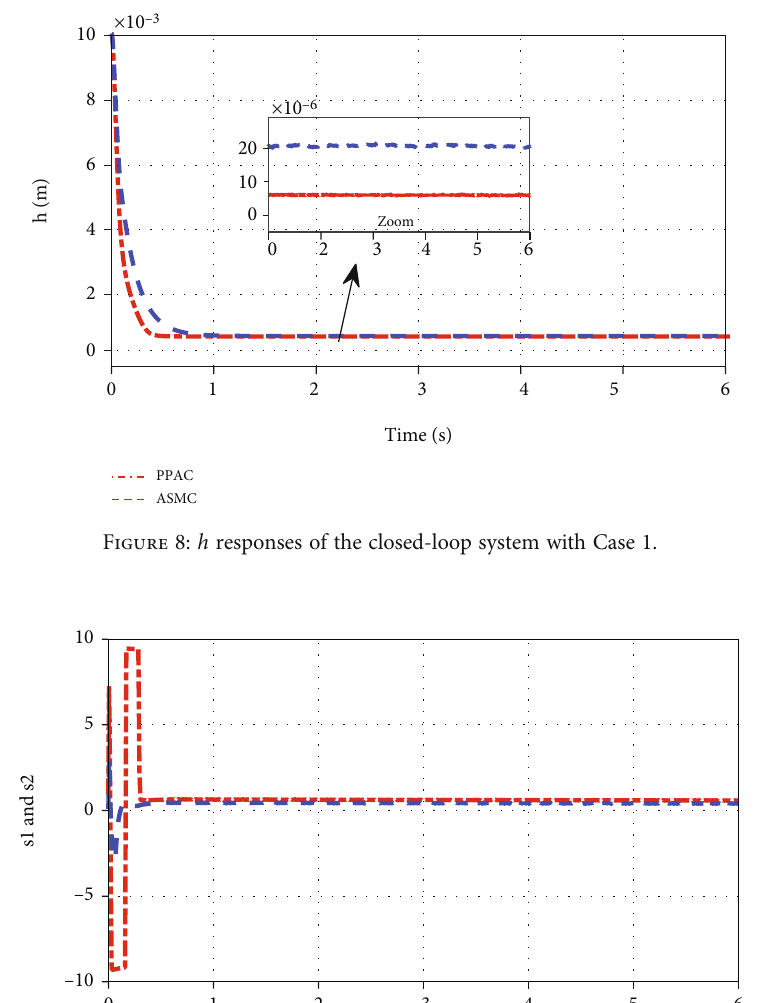
and s responses with Case 1 2